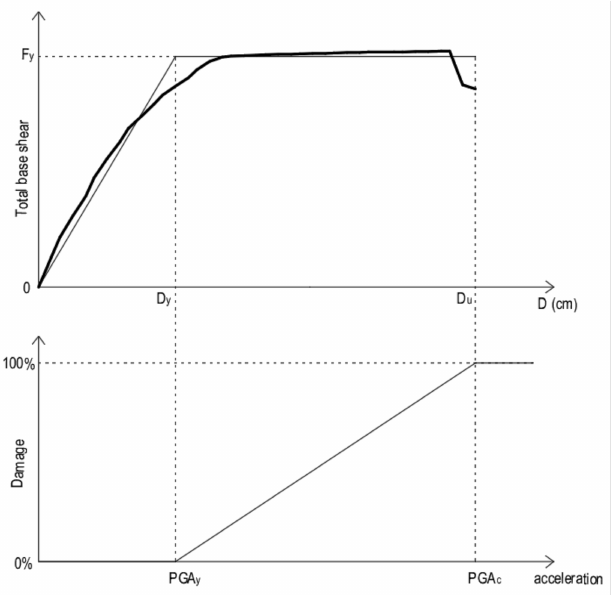
Figure 11. Pushover curve and tri-linear acceleration/damage